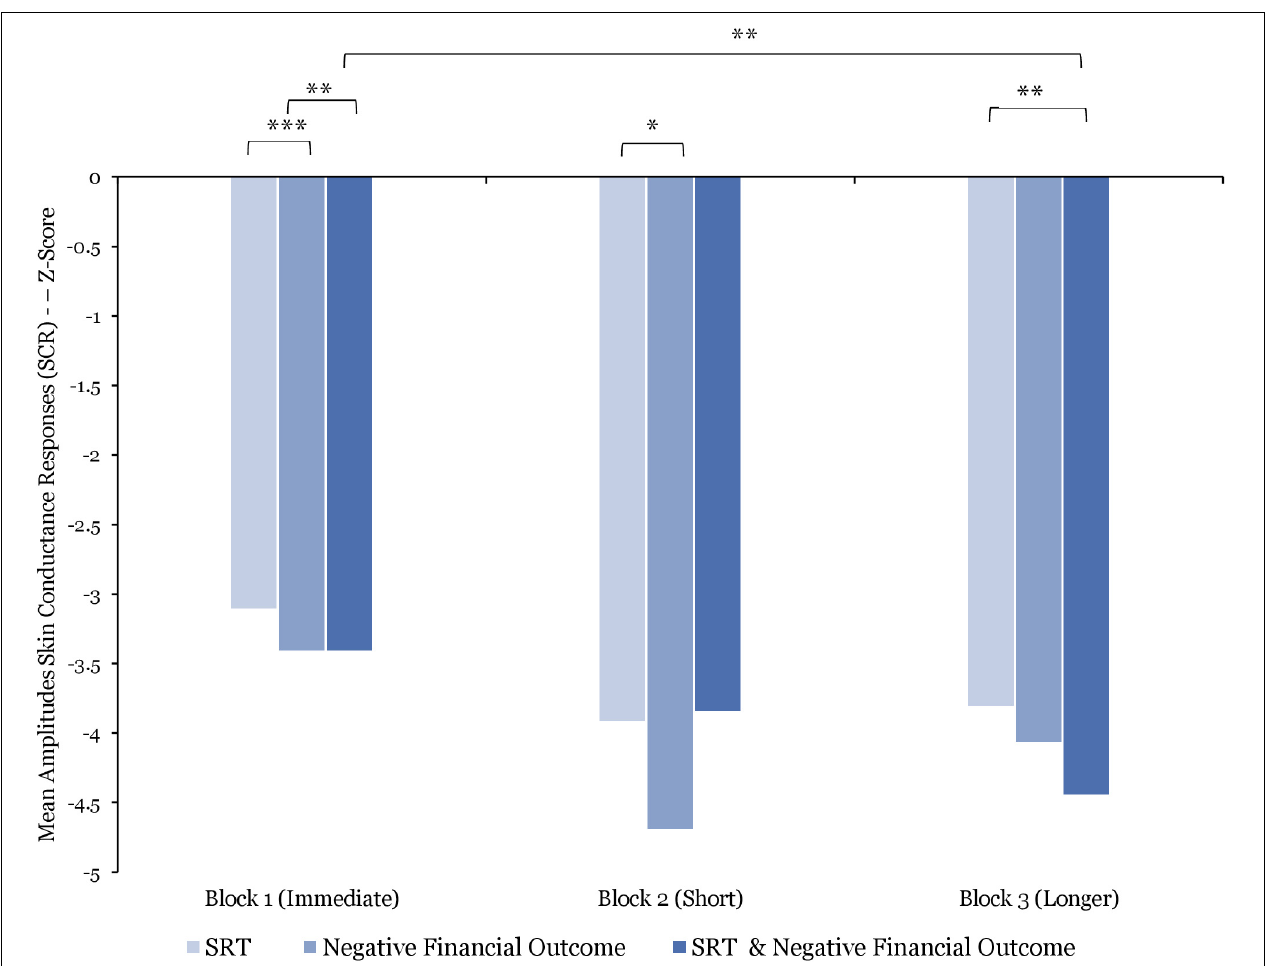
FIGURE 8 | Comparisons of mean amplitude skin conductance responses (SCR) (z-score) by stress manipulations and by blocks. Significant differences are marked as ∗ p < 0.05; ∗∗ p < 0.01; ∗∗∗ p < 0.001.